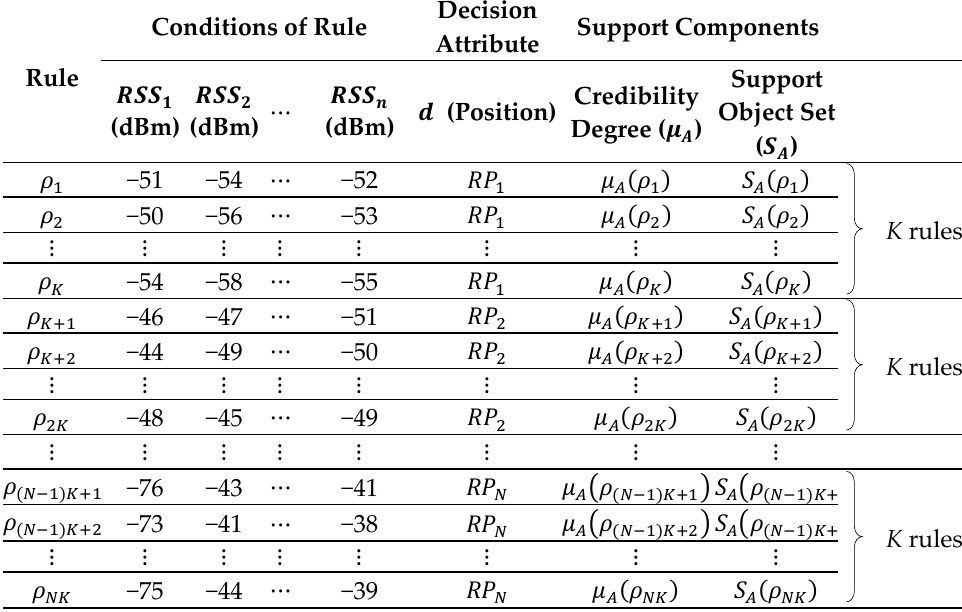
Algorithm 1: The Construction of a Fingerprinting Decision Rules Database for IPS Table 3. The structure of the fingerprinting decision rules database. Table 3. The structure of the fingerprinting decision rules database.